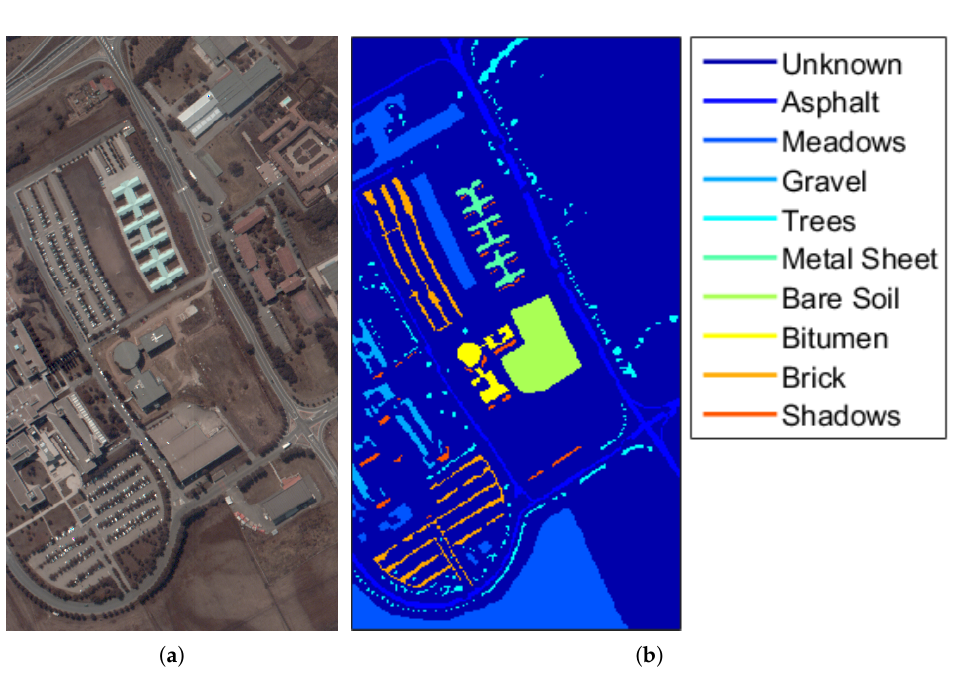
Figure 3. University of Pavia: ( a ) false color composite image (R:40,G:20,B:10); ( b ) ground reference